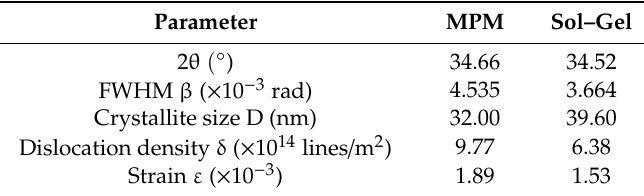
Table 1. Structural parameters of ZnO thin films prepared via two different synthesis routes. FWHM—full width at half-maximum.